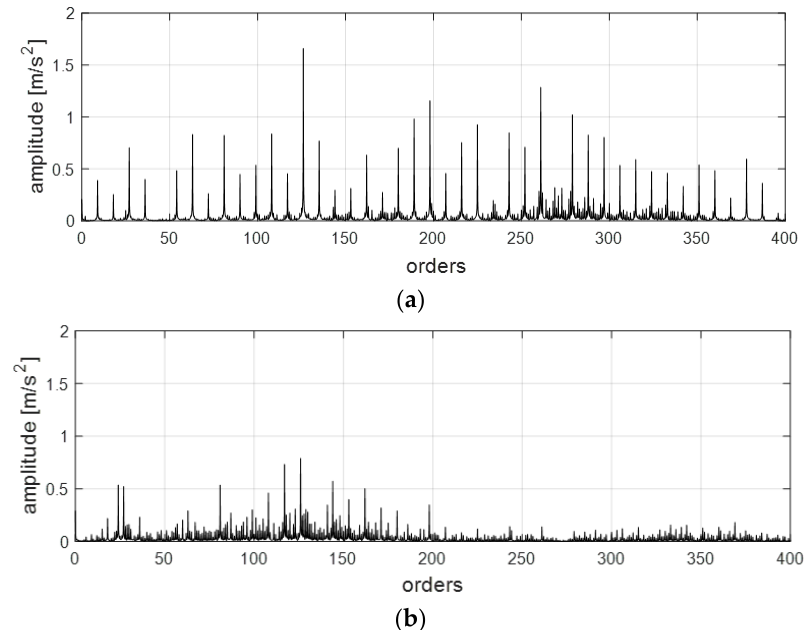
Figure 11. FFT of the synchronous average for ( a ) the flawless pump and ( b ) faulty pump for the signal acquired with sensor 2 (1500 r/min, 150 bar).